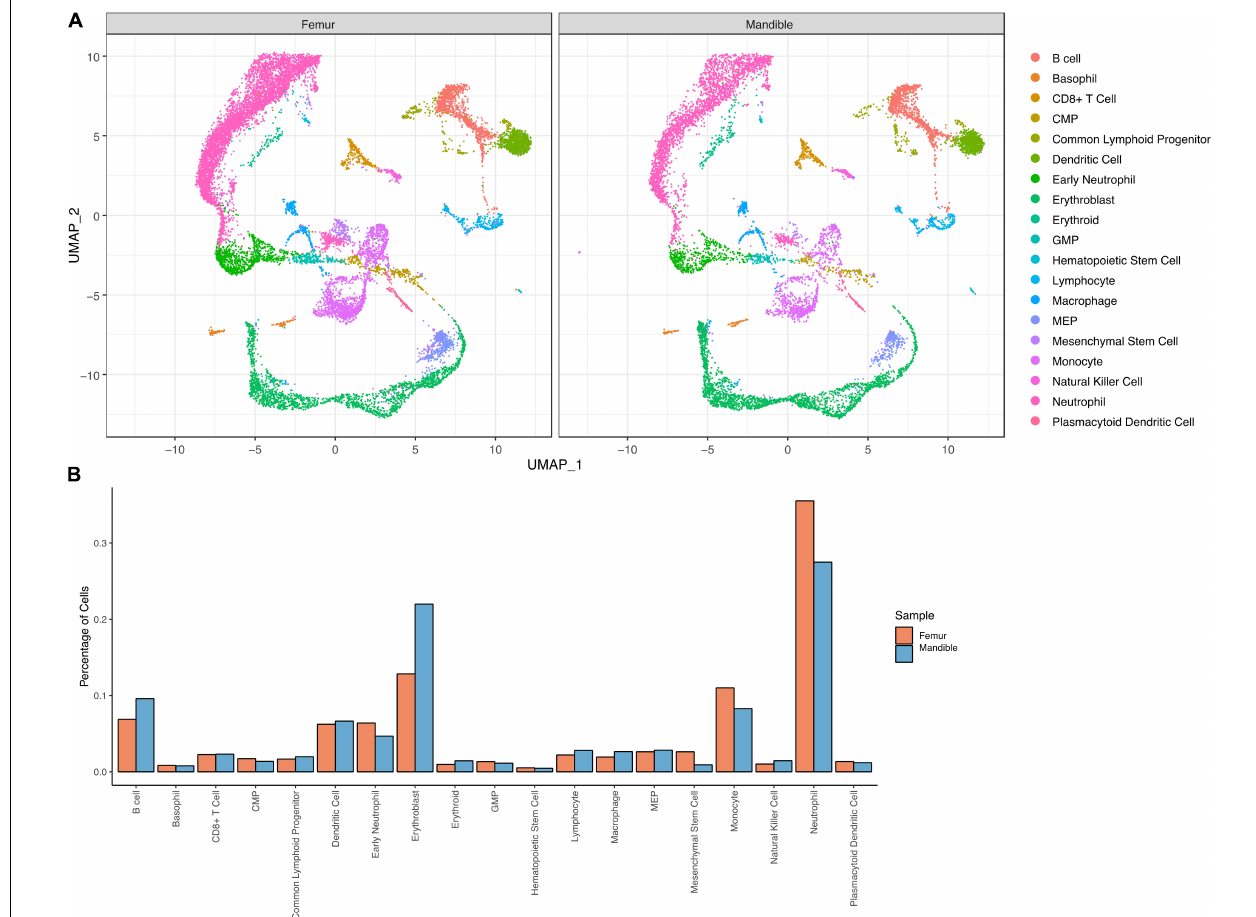
FIGURE 5 | Transcriptional profiling of bone marrow-derived cells reveals slightly distinct differentiation landscapes in fBM and mBM. (A) UMAP of femur and mandible samples displayed individually. (B) The percentage of cells in each annotated cluster for both the femur (orange) and mandible (blue), plotted as a percentage of total cells sequenced in each